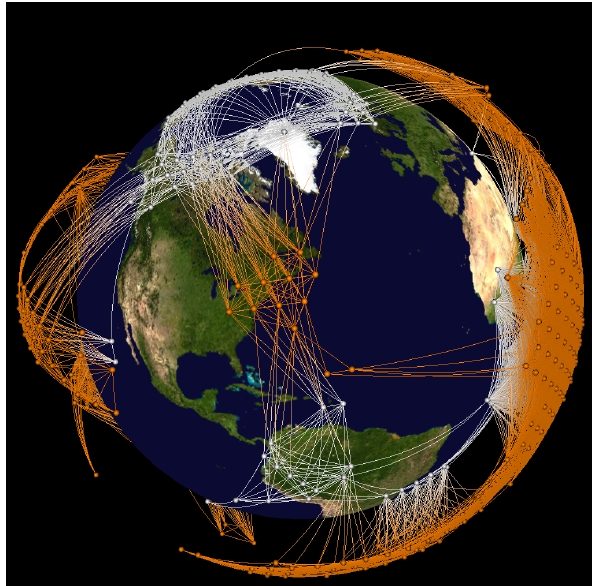
Figure 21. Coupled climate network constructed from the geopo- tential height field on two isobaric surfaces (GTX): near-surface (1000mbar, white nodes) and upper troposphere (600mbar, red nodes). The network visualisation has been filtered to highlight nodes with large cross-betweenness indicating regions that are po- tentially important for mediating vertical interactions in the atmo- sphere’s geostrophic wind dynamics, e.g. the circumpolar band of high cross-betweenness nodes above the